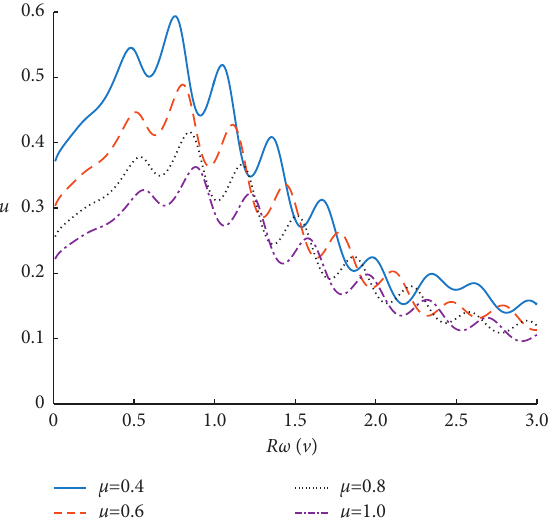
Figure 5: Curves of radial displacement varying with frequency for different order of fractional derivative.